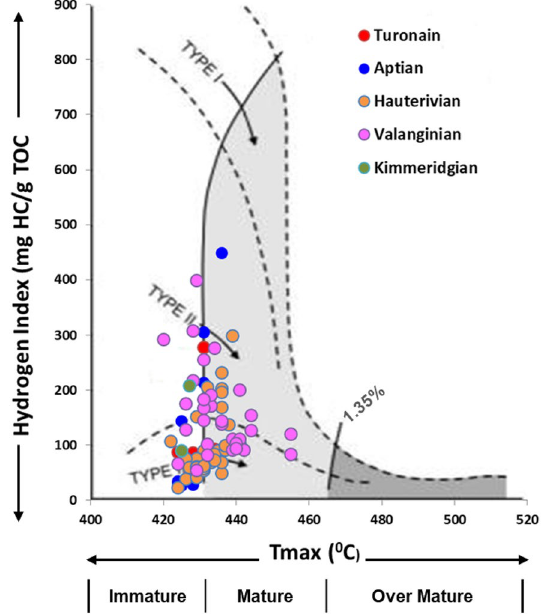
Fig. 8 Cross-plot of Rock–Eval T max versus hydrogen index (HI) showing the range in thermal maturity stages along with kerogen types of the source rock adapted from Agbor (2017)